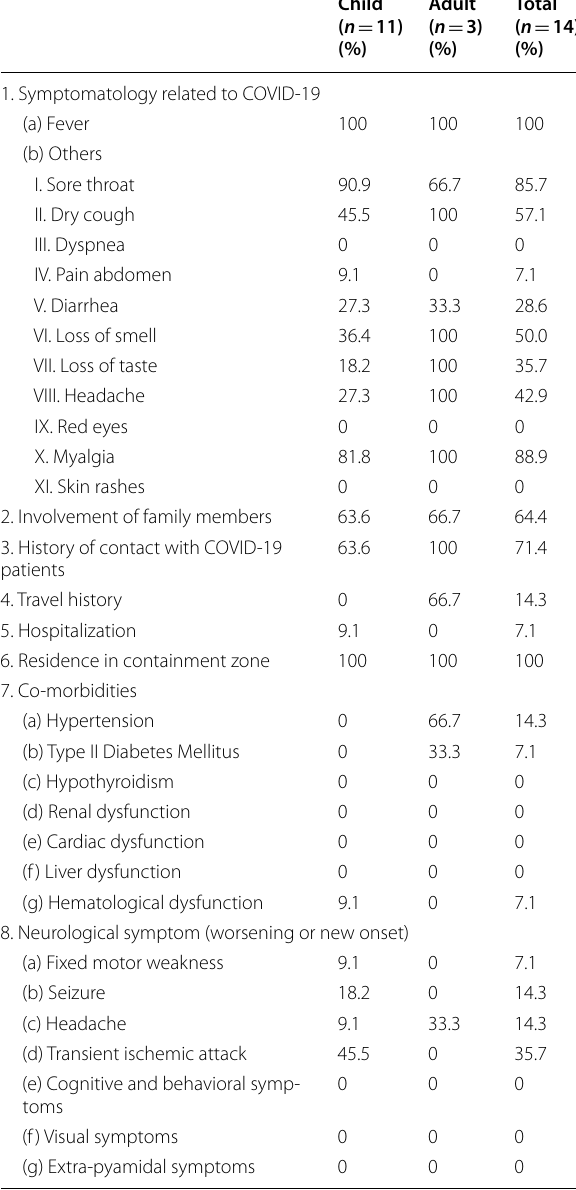
Table 2 Summarization of neurological status and details pertaining to COVID-19 symptomatology and behavior of suspected or confirmed COVID-19